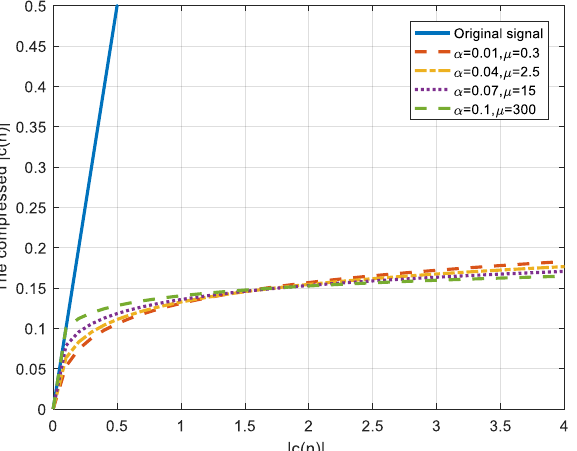
Figure 4. An example of the equivalent compression ratio with di ff erent values of α and correspondingly selected values of µ.